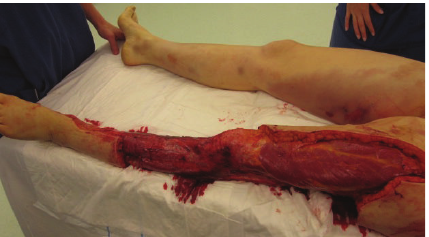
Figure 3: This figure shows patient 1’s extensive debridement of the left lower leg following identification of necrotic tissue. This theatre picture at the second look also shows the skin changes developing on the right leg, a late clinical